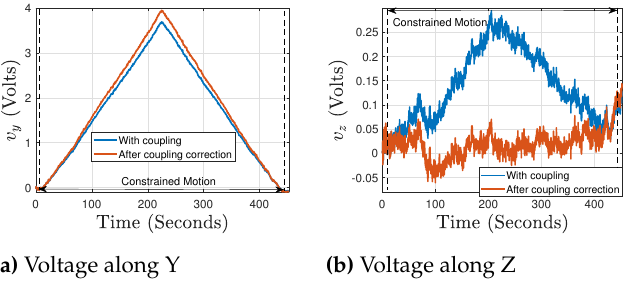
Figure 11. Voltage measured before and after coupling correction, against the external force along